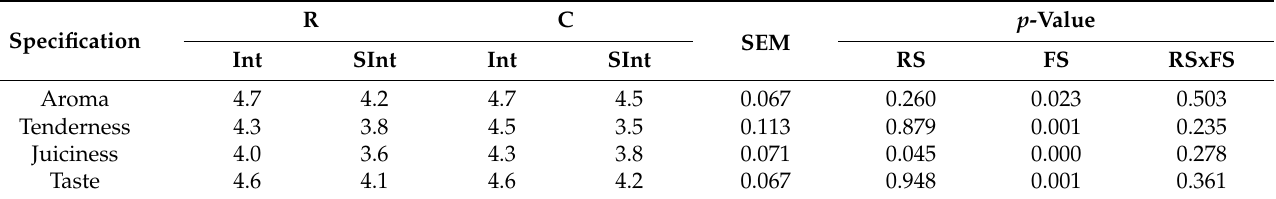
Table 3. Sensory assessment results of the longissimus lumborum